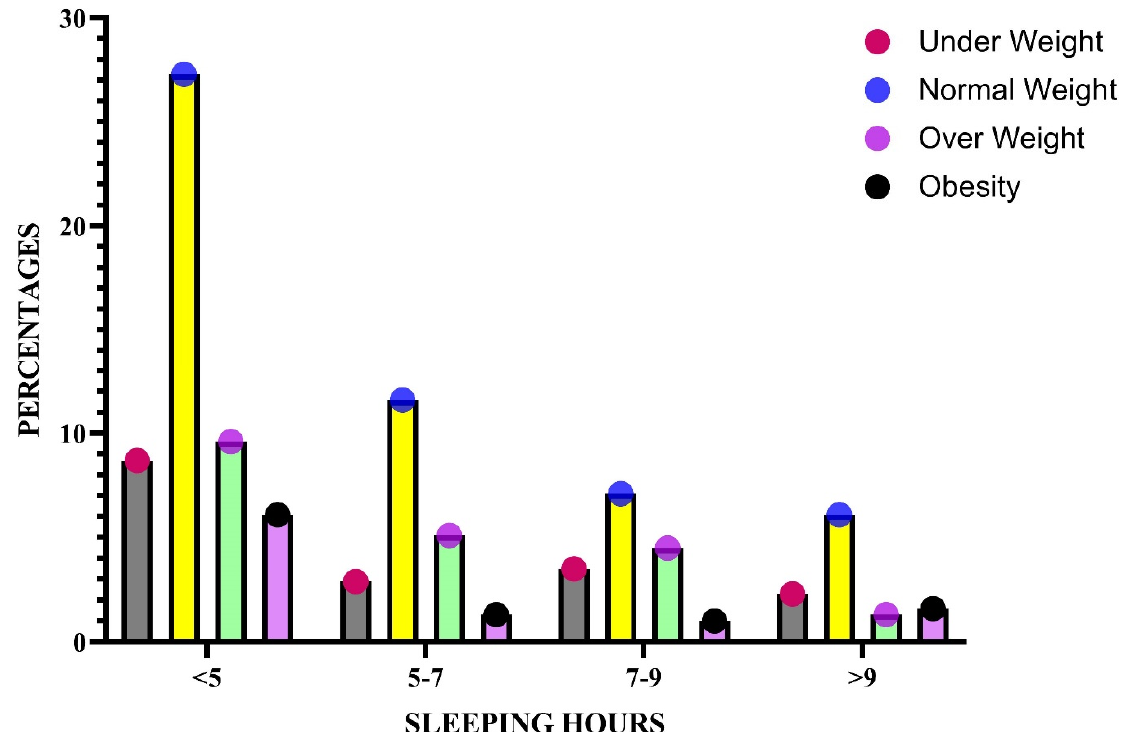
Figure 1. Sleeping patterns are characterized according to BMI group